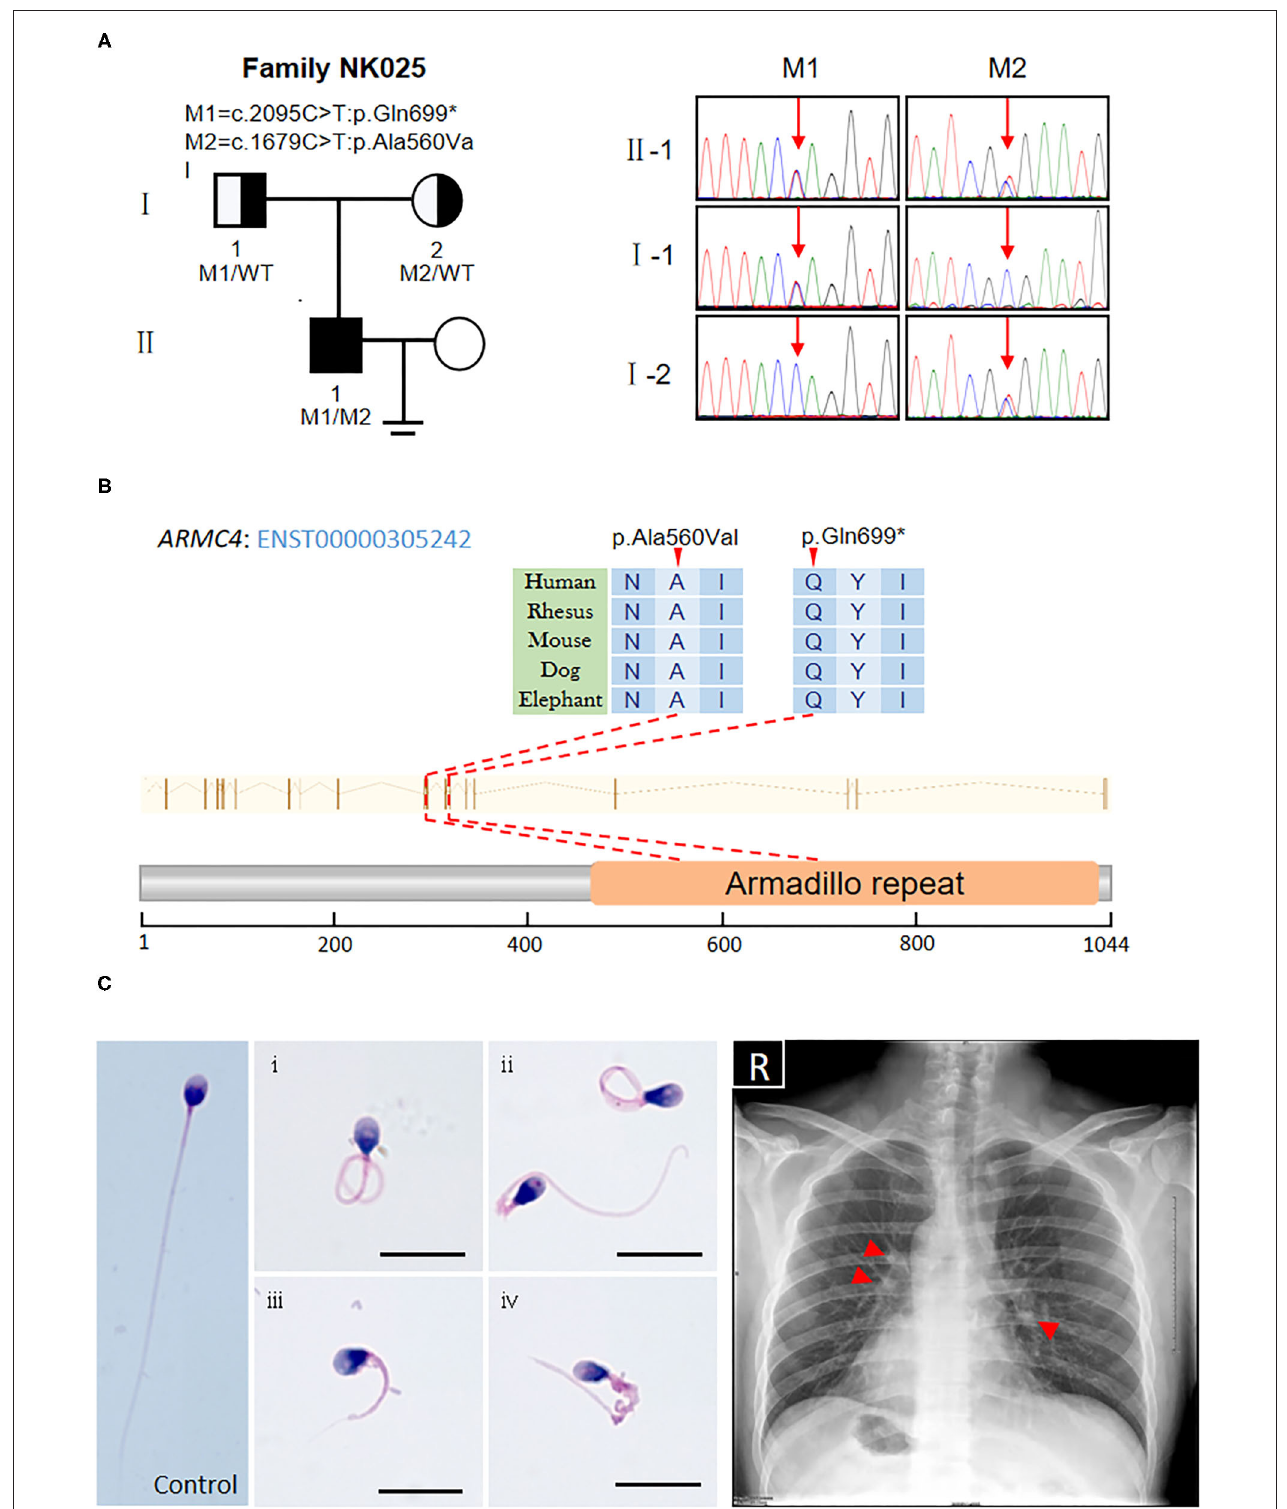
FIGURE 1 | Identification of novel biallelic ARMC4 mutations in a Chinese man with left/right body asymmetry and oligoasthenospermia-associated male infertility. (A) The pedigree of the investigated men affected by biallelic mutations in ARMC4 . Sanger sequencing results are shown on the right. Red arrows indicated the mutated